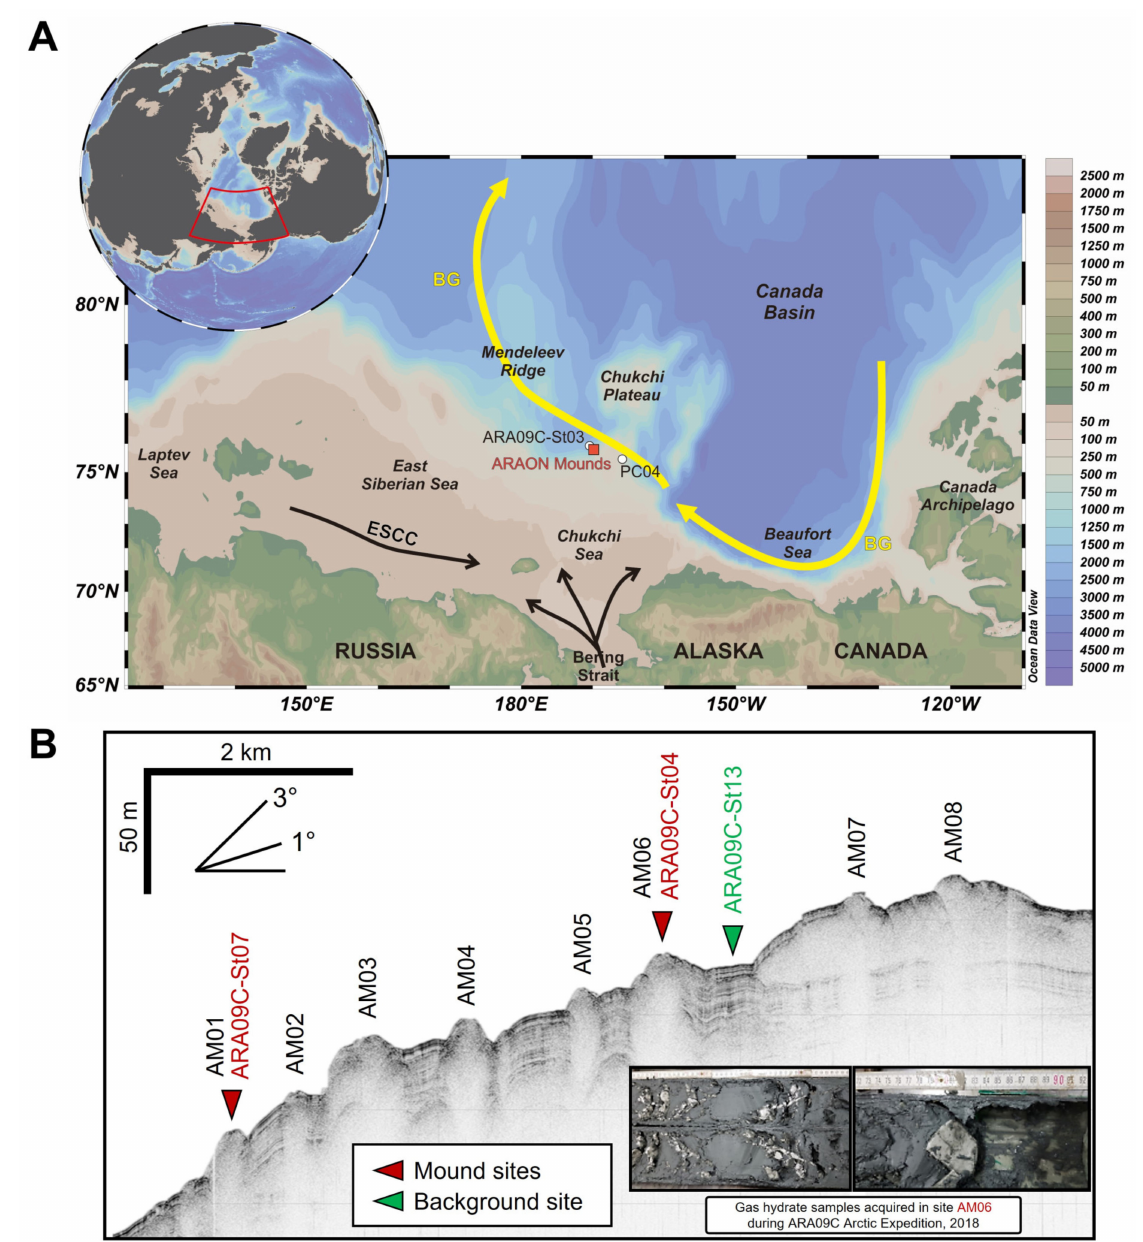
Figure 1. ( A ) Schematic map showing the location of ARAON mounds (red square) in the present study and sediment core ARA09C-St03 [23] used for comparison. The circulation paths (arrow) are modified from Darby and Bischof [24] and Kobayashi et al. [25]. BG: Beaufort Gyre. ESCC: East Siberian Coastal Current. ( B ) Sub-bottom profiling image for the ARAON Mounds (AMs) and the pictures for the gas hydrate samples acquired by gravity coring for the sea mound structures modified from Jin and Onboard ship scientific party